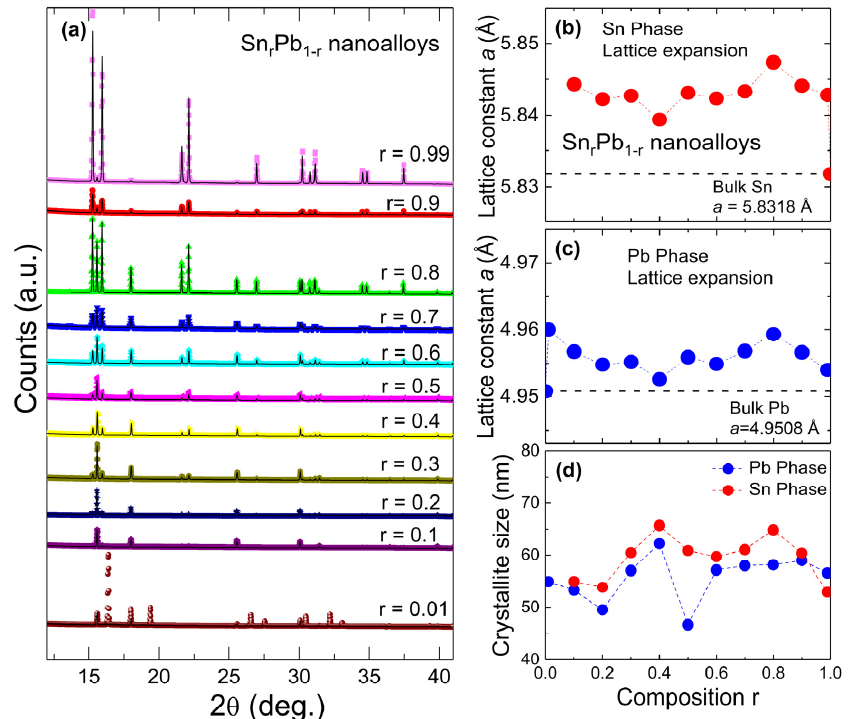
Figure 3. ( a ) observed (colored crosses) and Rietveld refined (solid black lines) X-ray diffraction patterns of Sn r Pb 1-r nanoalloys; ( b , c ) the effect of strain on the lattice constant of Pb and Sn is plotted with respect to initial composition r. Lattice expansion was observed for both Pb and Sn phases; ( d ) the variation of crystallite size with composition r for Pb and Sn phases.